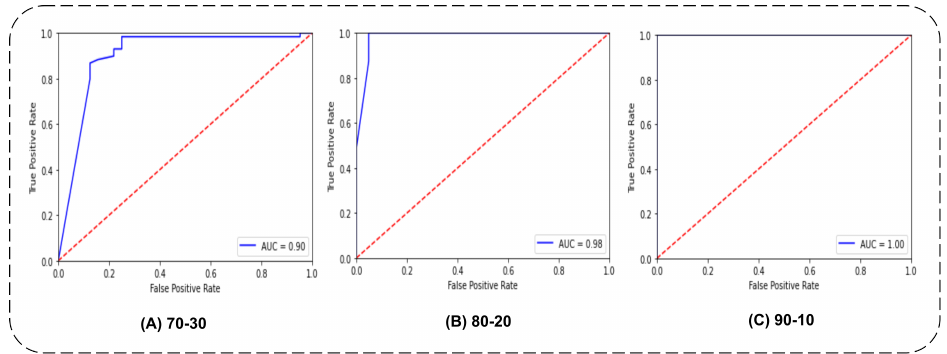
Figure 3. The testing data predictions of three trained classifiers of mini-BERT-based transfer learning. With 70% training data, (A) shows an AUC value of 0.90, which is good, although